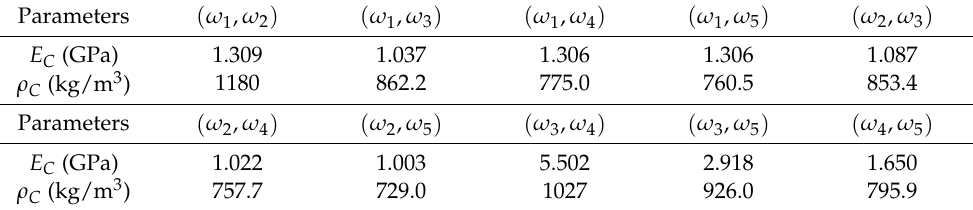
Based on the curves in Figure 9a, the ∆ E C / E C values calculated from ( ω 1 , ω 2 ) , ( ω 1 , ω 3 ) , ( ω ) , and ( ω ) are relatively lower than other frequency pairs at the 50 µ m posi- 1 , ω 4 1 , ω 5 tion. As for the ∆ ρ C / ρ C curves of different frequency pairs shown in Figure 9b, ( ω 1 , ω 5 )